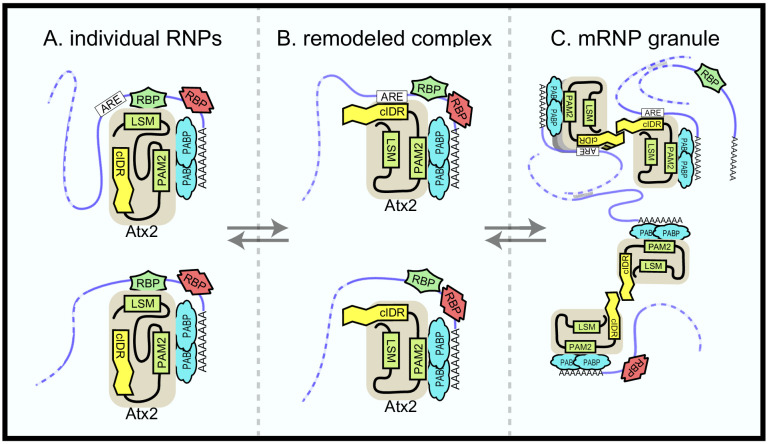
Ataxin-2 domains in mRNA target regulation.A model to explain the current and previous observations on Ataxin-2 as well as its function in mRNA regulation. (A) Ataxin-2 does not make direct contact with mRNAs in soluble mRNPs. Instead, it is recruited to RNA by other RBPs that bind to structured Like-Sm (Lsm) (or Lsm-associated [LsmAD]) domains. In these soluble mRNPs, the cIDR is buried and inaccessible. One class of mRNP (above) contains AU-rich elements (AREs); the second class below (e.g., per in Drosophila) does not. (B) Under specific signaling conditions (e.g., stress), RBP–Atx2 interactions are prevented. In these ‘remodeled’ mRNPs, the Atx2-cIDR is exposed. We speculate that a segment of this intrinsically disordered domain (IDR) directly binds to nearby AREs (or to ARE-binding proteins), while other segments of the IDR mediate multivalent interactions that contribute to mRNP condensation. (C) Ataxin-2 cIDR interactions enable mRNP assembly into granules, facilitated by RNA–RNA crosslinks and interactions mediated by other RBPs (e.g., G3BP/Rin). These RNP granules may include both ARE-containing mRNAs (edited) and mRNAs that do not. Note that additional RBPs (red) could determine not only Atx2 proximity to specific mRNAs (leading to editing) but also the effect of Atx2 on mRNA translation and/or stability. These and alternative models remain to be tested.